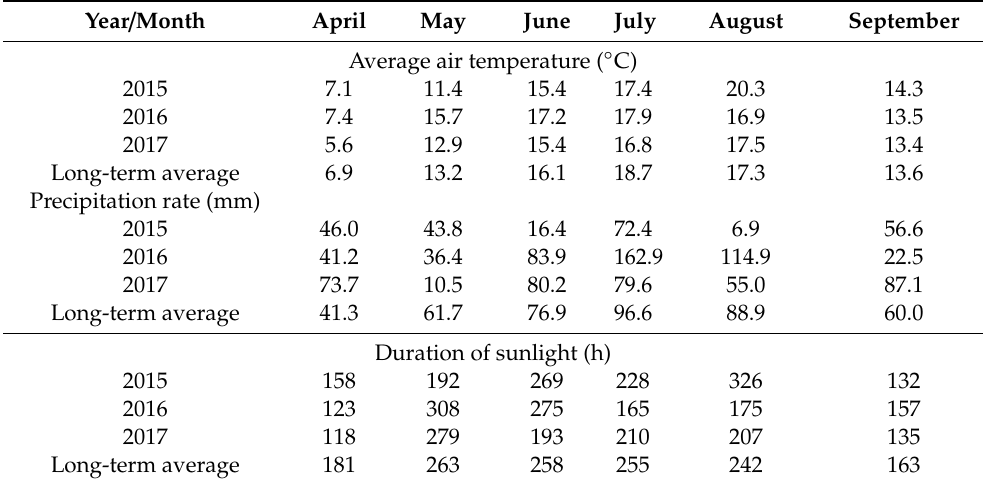
Table 2. Meteorological conditions during the sugar beet vegetative periods, Kaunas Meteorological